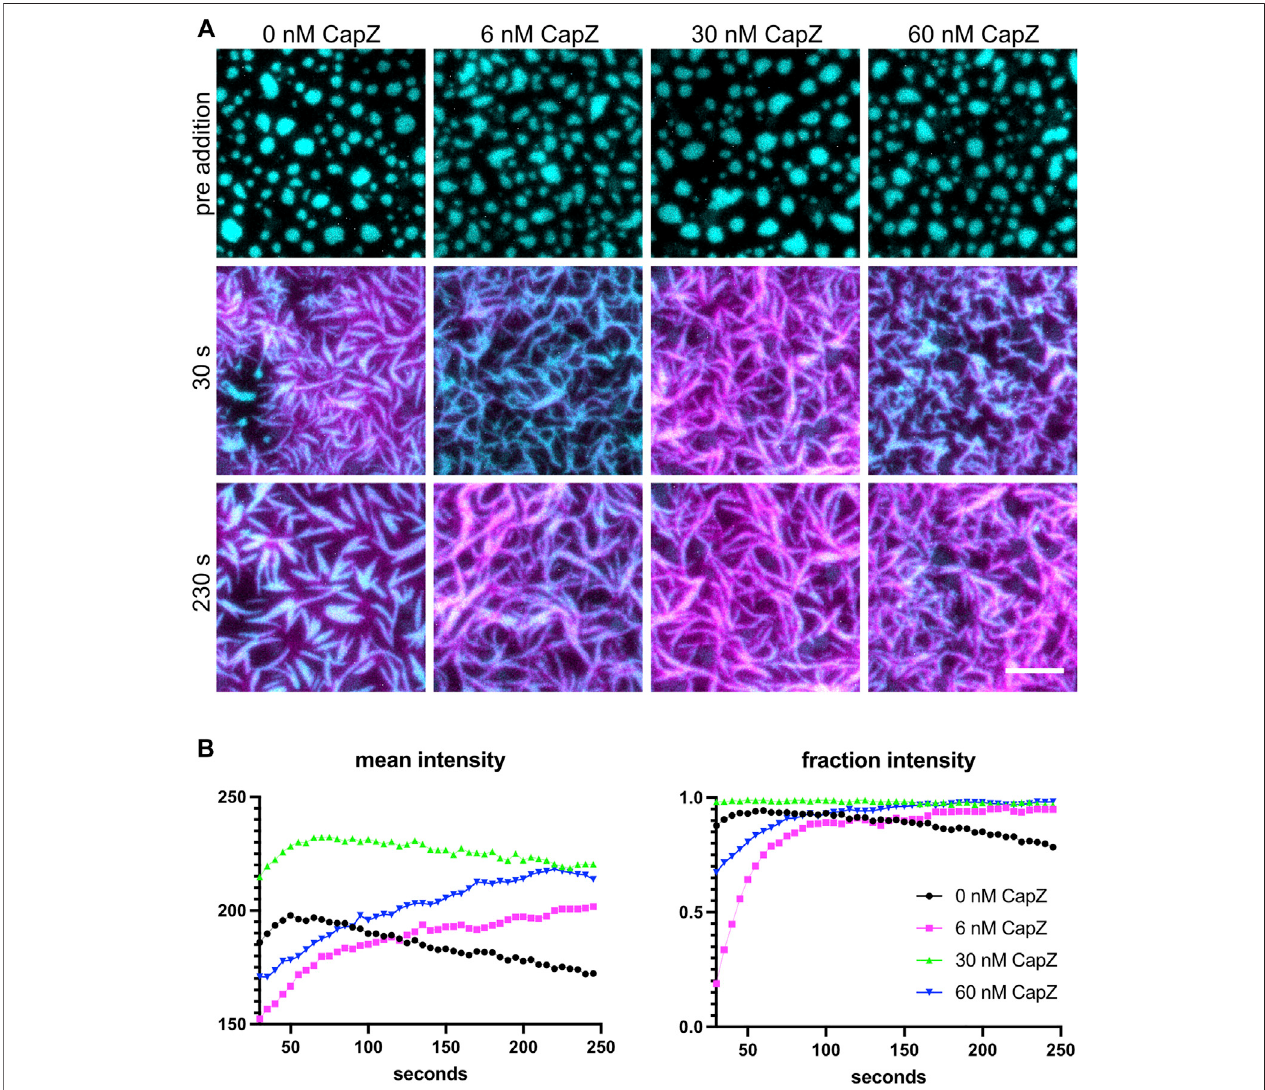
FIGURE 5 | Actin polymerization with different levels of capping proteins. (A) 1 µM actin (5% labeled by Alexa647) polymerization is induced by 3 nM Arp2/3, 0.25 µMATP,0.1 mMMgCl 2 and0.1 mM EGTA,withdifferentamountsofCapZ included inthesystem(indicatedabove eachimage),fromclustersmadefrom500 nM Nck,250 nM N-WASPand1.25 nMHis 8 -nephrin(15%labeledbyAlexa405)onthemembrane.IndividualimagesareTIRFimageoverlaysofnephrin-405shownincyan and actin-647 shown in magenta. Total Internal Re fl ection Fluorescence (TIRF) penetration depth 200 nm for all channels. Scale bar, 5 µm. (B) Quanti fi cation of actinmeanandfractionintensityovertimefortheconditionsisshownin (A) .Actinwasselectedbyselectingtheintensitythresholdbetween250and65535theindividual 16-bit images, values for each frame are calculated as described in Section 4.4